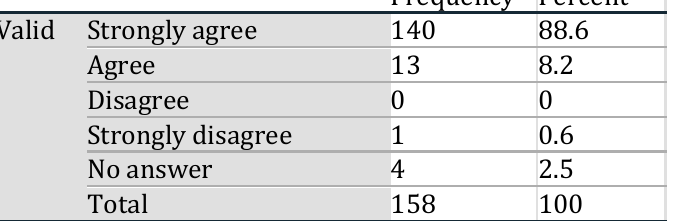
Table 2. The importance of knowledge about children’s